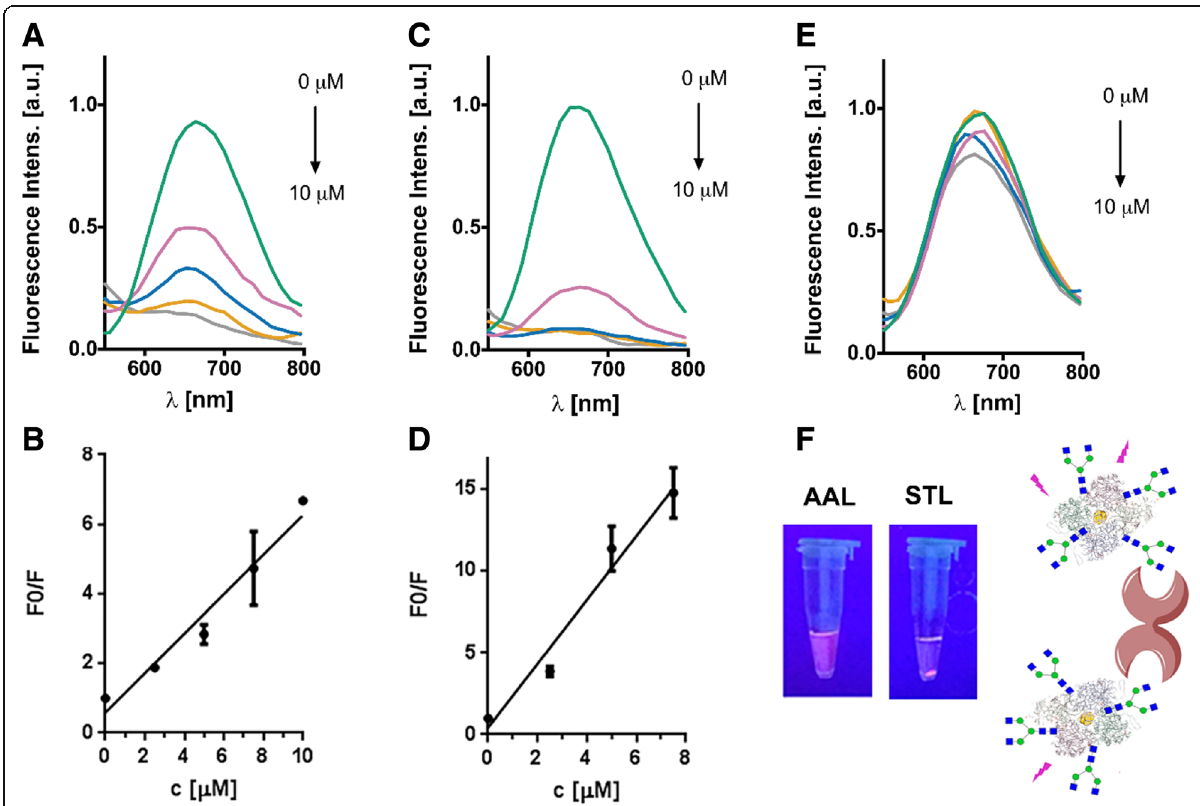
Fig. 5 Lectin agglutination assays of G0-OVA-AuNCs (5/6). a Representative fluorescence spectra of the supernatants of OVA-G0 (5/6)-AuNCs solutions after incubation with BSL-II. b Representation of F0/F against increasing concentrations of BSL-II. c Representative fluorescence spectra of the supernatants of OVA-G0 (5/6)-AuNCs solutions after incubation with STL. d Representation of F0/F against increasing concentrations of STL. e Representative fluorescence spectra of the supernatants of OVA-G0 (5/6)-AuNCs after incubation with AAL. f Image corresponding to incubation of G0-OVA-AuNCs (5/6) with AAL and STL, under UV light illumination (365 nm). After incubation with STL, a visible precipitate was formed. On the right side: schematic illustration of binding between G0-OVA-AuNCs and plant